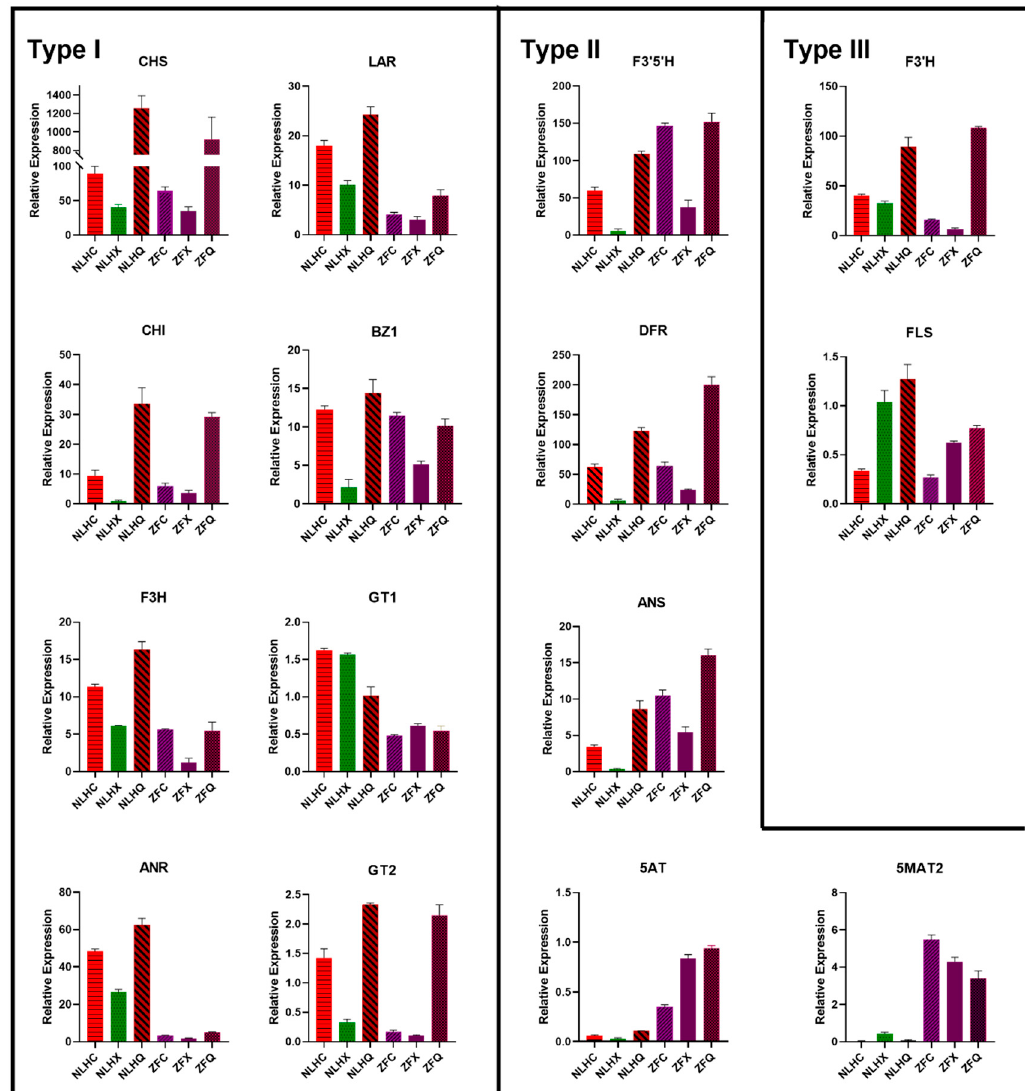
Figure 4. Expression levels of anthocyanin-related genes in L. formosana with different leaf colors. Each sample was tested in triplicate in qRT-PCR reactions, and vertical bars indicate standard errors.